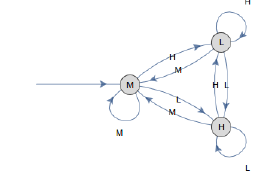
Figure 1: An accommodating strategy, starting to play Medium, then playing best response to the pre- vious move of the opponent